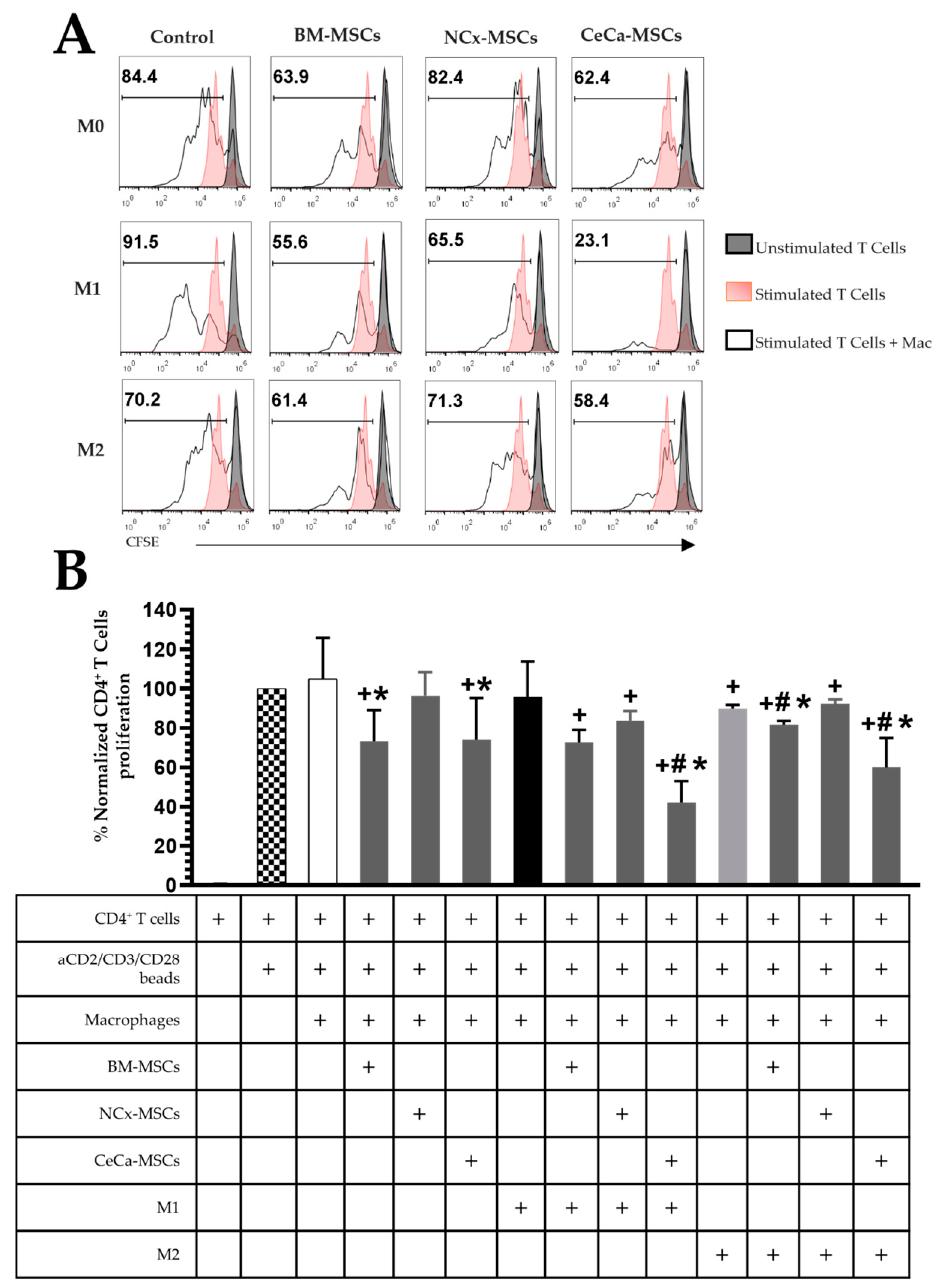
Figure 4. CeCa-MSCs increase the capacity of macrophages to decrease CD4 + T cell proliferation. ( A ) Representative histogram of the percentage of CFSE-labeled CD4+ T cell proliferation. ( B ) Bar graph of the normalized percentage of proliferative CD4+ T cells. Bar graphs represent the mean